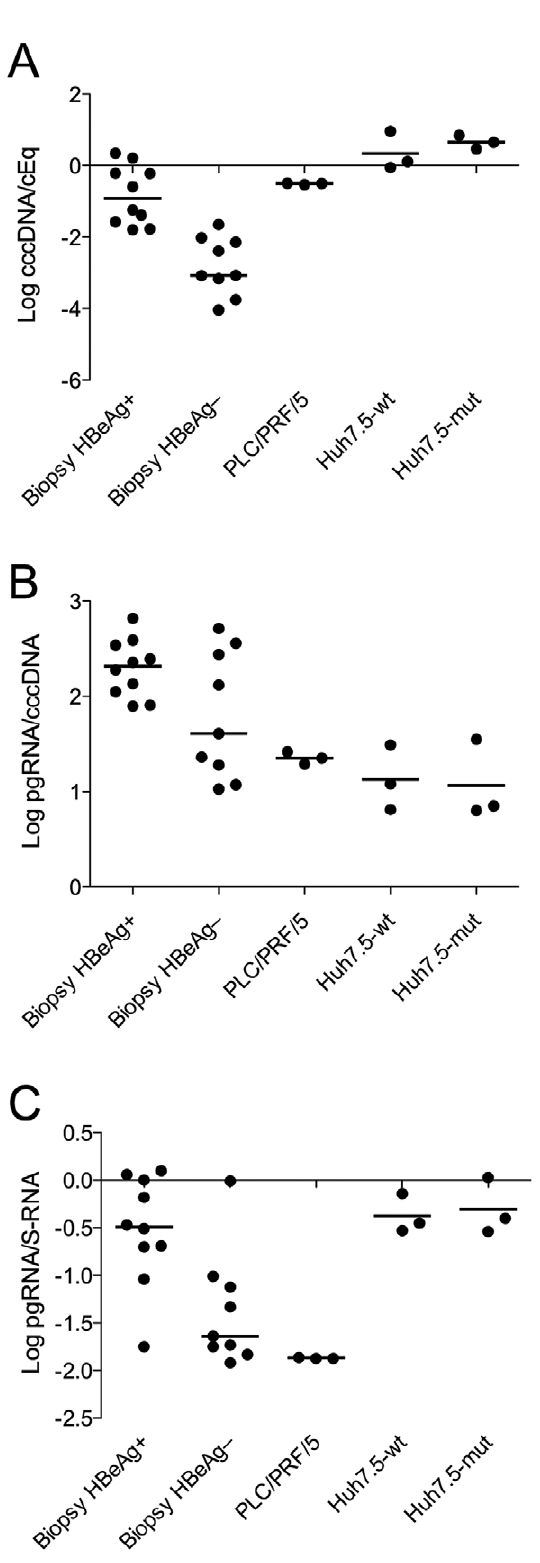
Figure 1. Levels of cccDNA and HBV RNA in vivo and in vitro. The cccDNA levels (A) and pgRNA per cccDNA (B), as well as pgRNA/ cccDNA ratios (C) were higher in liver tissue from HBeAg-positive as compared with HBeAg-negative patients. In PLC/PRF/5 cells, the cccDNA PCR amplifies integrated HBV DNA (a segment containing the promoter for pgRNA). In these cells which contain multiple